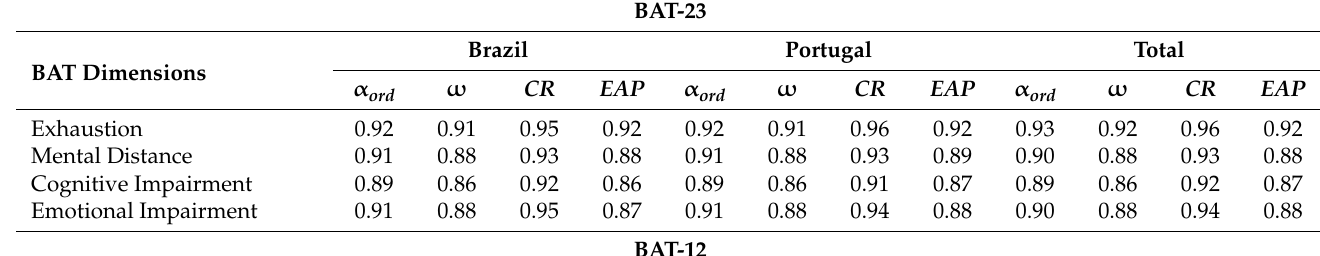
Figure 3. Wright Map for BAT-23 for both samples. Ex—Exhaustion; MD—Mental Distance; CI— Cognitive Impairment; CI—Emotional Impairment. Each item has its four thresholds identified (i.e., t1, t2, t3, t4). Table 4. Reliability Estimates for the Sample from Brazil, Portugal, and Joint Data.